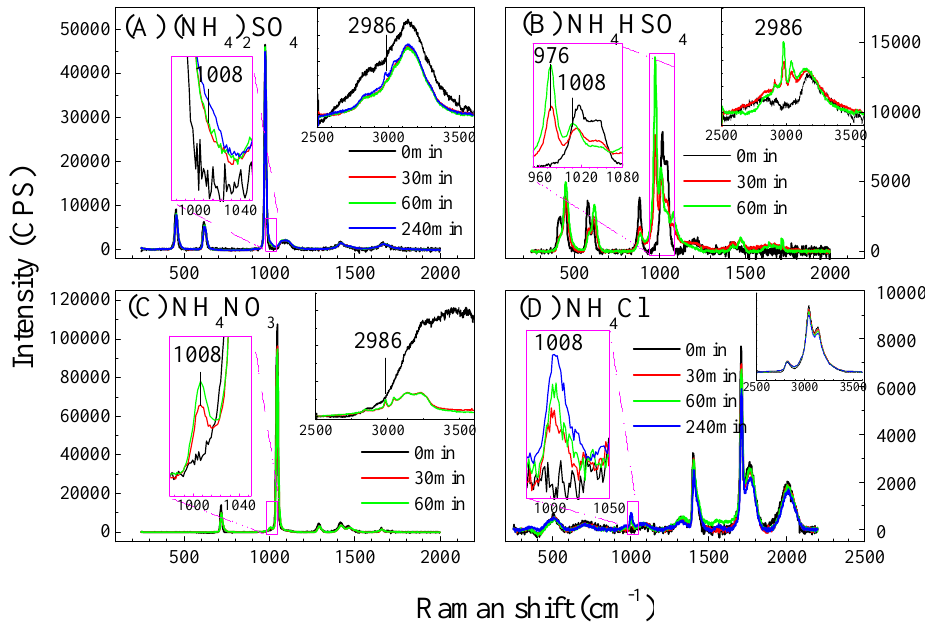
Fig. 2. Fig. 2. In situ Raman spectra for heterogeneous reactions of MA with ammonium salts at 298K. The insert graphs in purple boxes show the enlarged spectra in the range of 950–1080cm − 1 and those on the top right corner show the spectra in the range of 2500–3600cm − 1